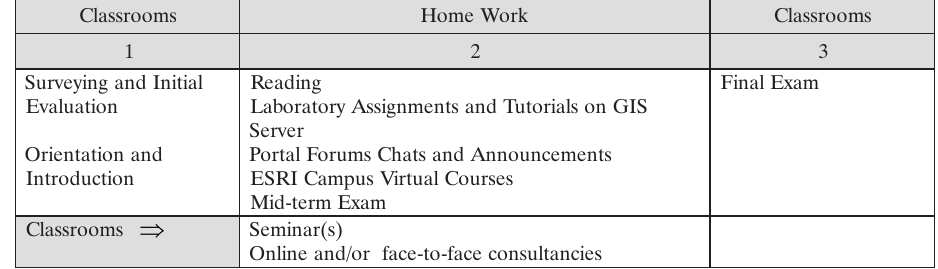
smoorssalC kroWemoH smoorssalC 1 2 3 laitinIdnagniyevruS gnidaeR noitaulavE SIGnoslairotuTdnastnemngissAyrotarobaL revreS dnanoitatneirO noitcudortnI